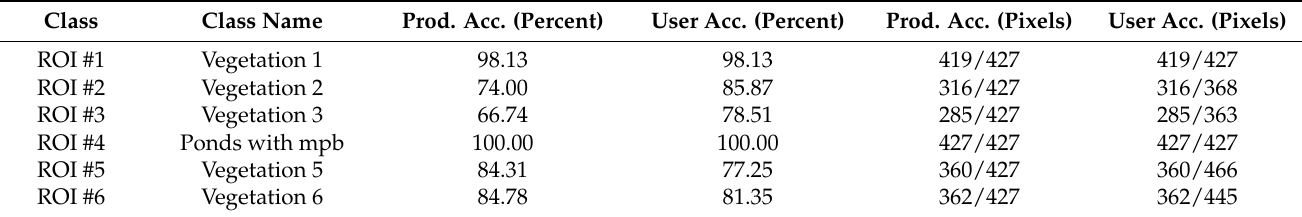
Table A2. Report for the accuracy of the comparison of classification results to Eq500, the equalized samples groups using 500 pixels for each class as reference. The table summarizes the producer accuracy and user accuracy in percentage and pixels for each